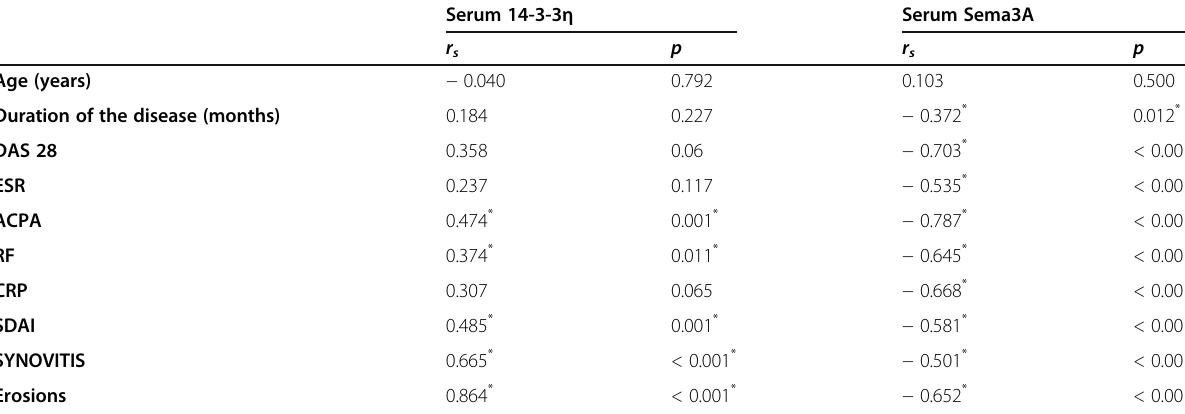
Table 3 Correlation between the two markers and different parameters in patients group ( n = 45)